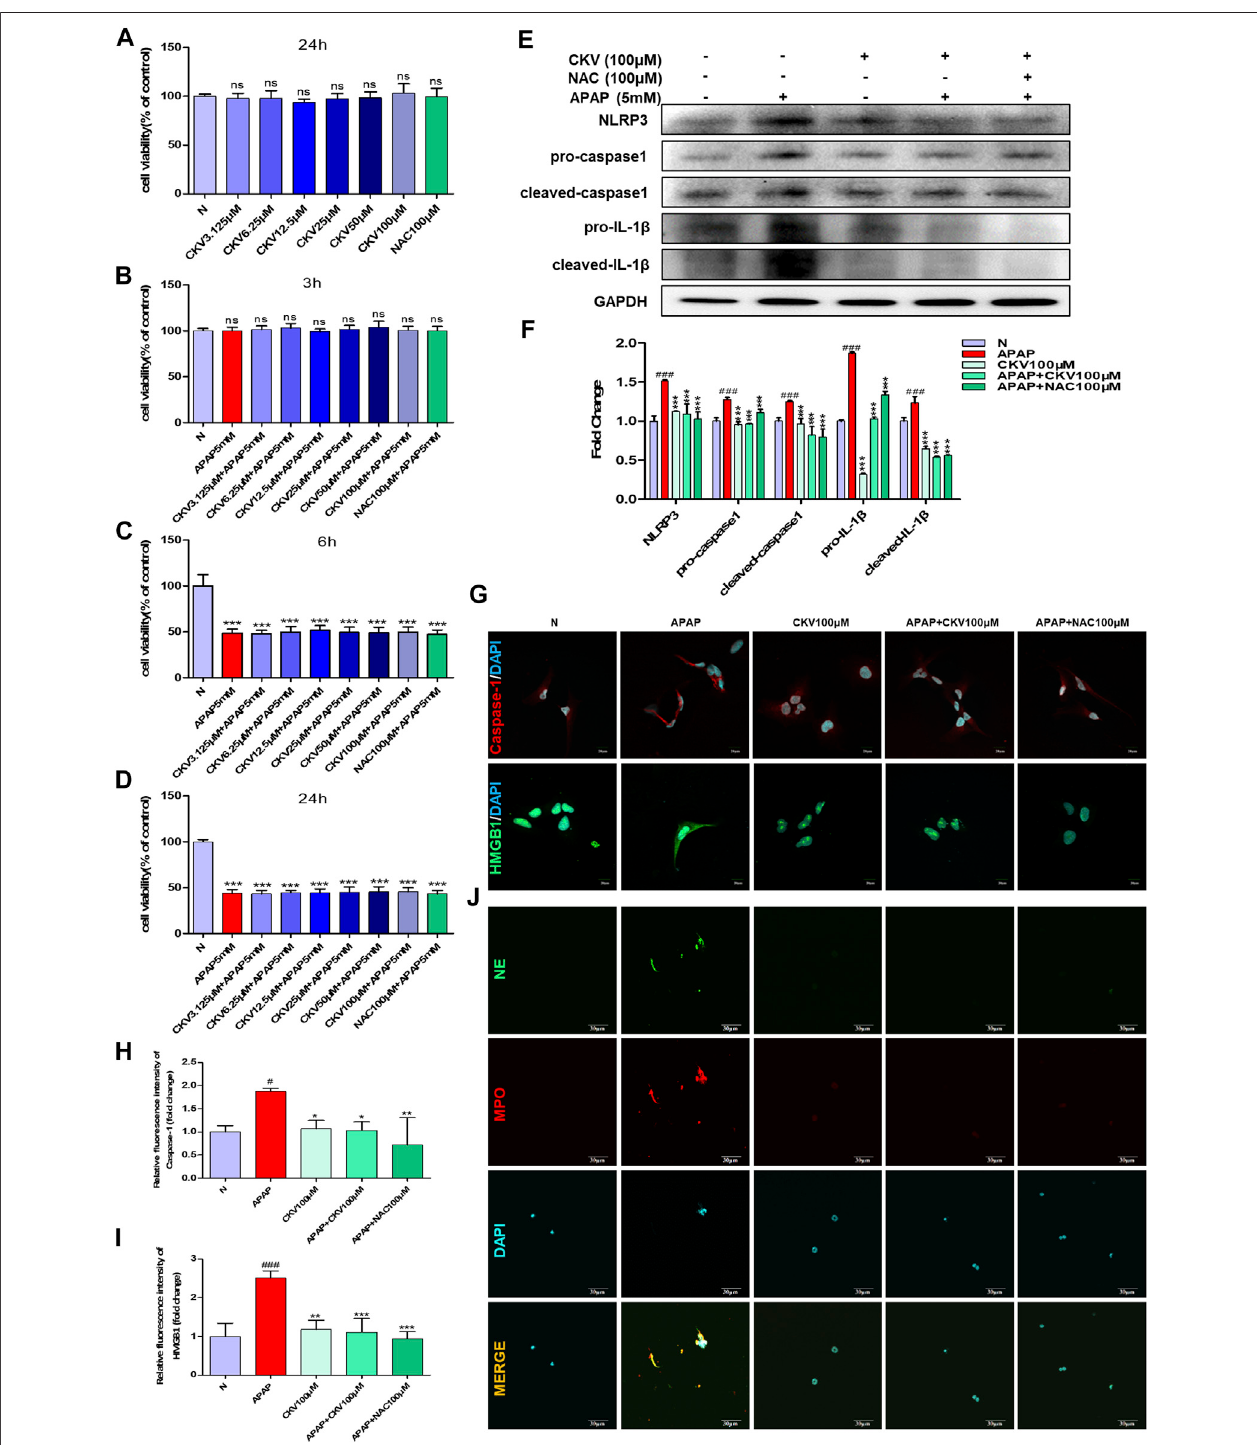
FIGURE8| CKVreducesliverdamagebyinhibitingthereleaseofHMGB1andtheactivationofCaspase-1inlivercellsafterAPAPstimulation,andtheformationof neutrophil NETs. (A) 24 h survival rate of AML12 cells stimulated by 3.125 – 100 μ M CKV and 100 μ M NAC. (B – D) 3.125 – 100 μ M CKV and 100 μ M NAC and APAP (5 mM)combinedtostimulatethesurvivalrateofAML12cellsat3,6and24 h (E,F) AML12cellsweresimultaneouslytreatedwith100 μ MCKVandAPAP(5 mM)for3 h to detect the protein expression and relative quantitative analysis of NLRP3, pro-caspase1, cleaved-caspase1, pro-IL-1 β and cleaved-IL-1 β . (G – I) Immuno fl uorescencestainingwasusedtodetecttheexpressionandrelativequantitativeanalysisofCaspase-1andHMGB1.Thered fl uorescentlabelisCaspase-1and the green fl uorescent label is HMGB1. (J) NE and MPO immuno fl uorescence staining. Green fl uorescence labeled NE, red fl uorescence labeled MPO, orange yellow